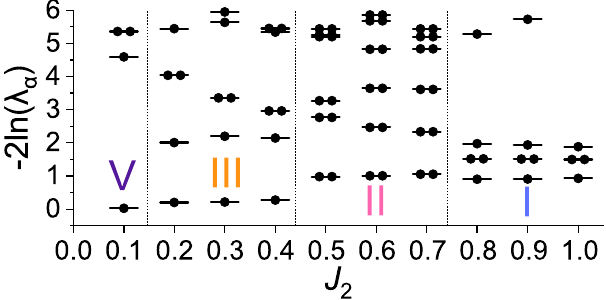
Fig. 7 Entanglement spectrum of the kagome strip chain with respect to J J = 0.9. Here, J J 1 and 2 are the exchange interactions shown in Fig. 1. 2 at 1 The cluster used in the calculations is the open boundary condition for L = 80( N = 5 × 80), where L is the number of fi ve-site units in the kagome strip chain. In addition, λ 2 α are the eigenvalues of the reduced density matrix, and α is an index of the eigenvalues. The Roman numerals correspond to the phases shown in Fig. 2. The vertical dotted lines represent the phase boundaries determined by the entanglement spectrum and the magnetic structures. The horizontal bars indicate the values of λ α , and the fi lled circles indicate the degeneracy of λ α .